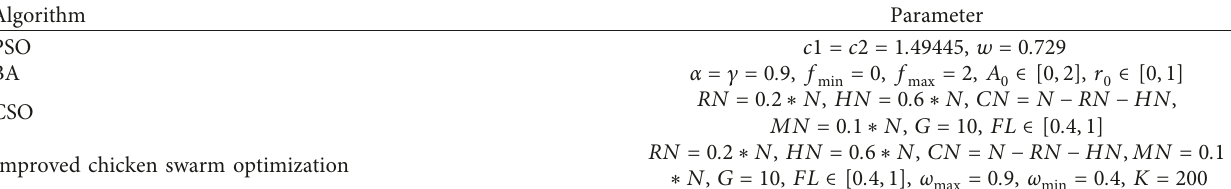
Table 1: The related parameter value.